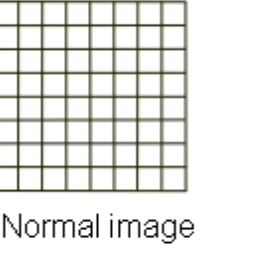
Figure 3. Radial distortion diagram .